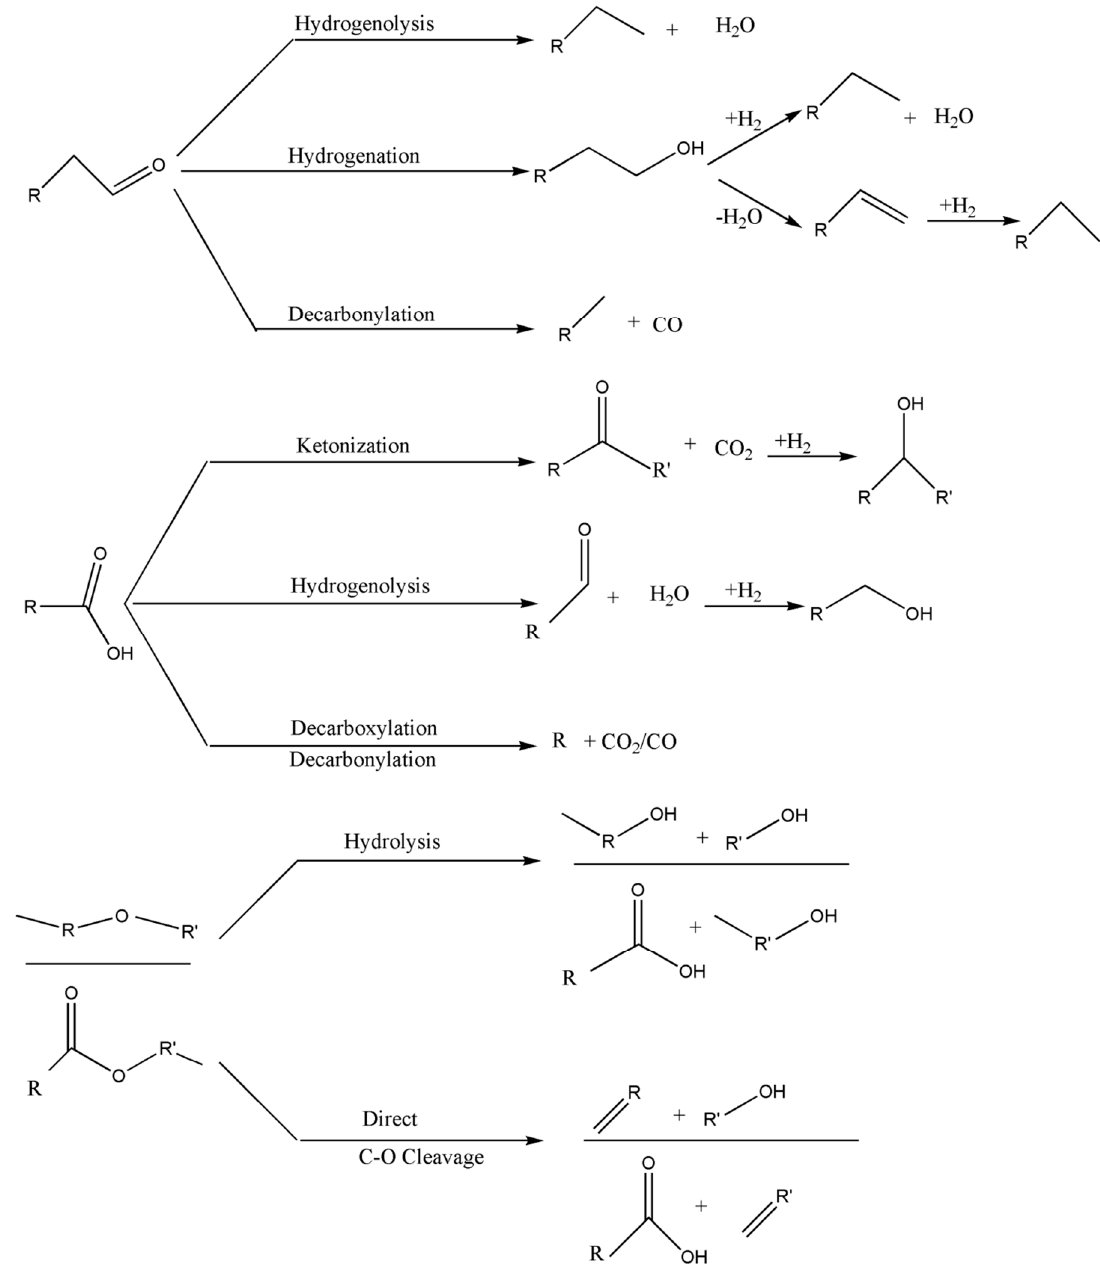
Figure 5. Hydrodeoxygenation (HDO) pathways depending on the oxygen moieties